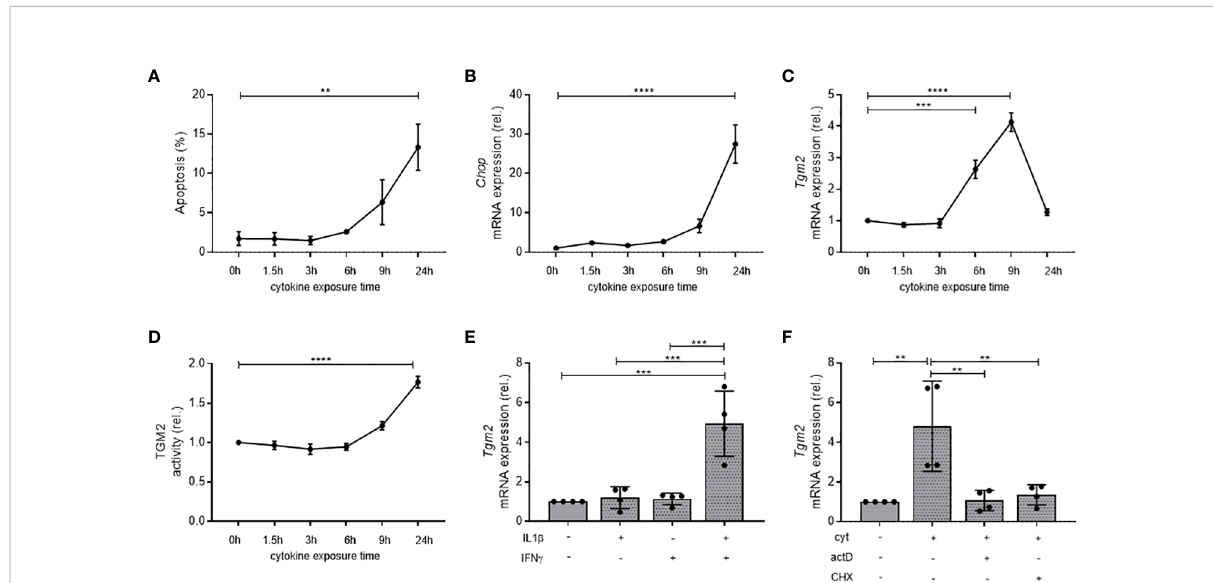
FIGURE 1 Transcription and activity of Tgm2 in b -cells is synergistically induced, transcriptionally regulated by cytokines, and precedes cell death and ER stress. Apoptosis (A) , Chop mRNA (B) , Tgm2 mRNA (C) and TGM2 activity (D) in INS-1E cells exposed to IL1 b (10 U/mL) and IFN g (500 U/mL) during different exposure times. (E) Tgm2 mRNA levels in INS-1E cells exposed to IL1 b and/or IFN g for 9 hours. (F) Tgm2 mRNA levels in INS-1E cells exposed to IL1 b , IFN g and actinomycin D (actD; 1 m g/mL) or cycloheximide (CHX; 1 m g/mL) for 9 hours. Data are shown as mean with SEM. One-way ANOVA with correction for multiple testing, **p<0.01, ***p<0.001 and